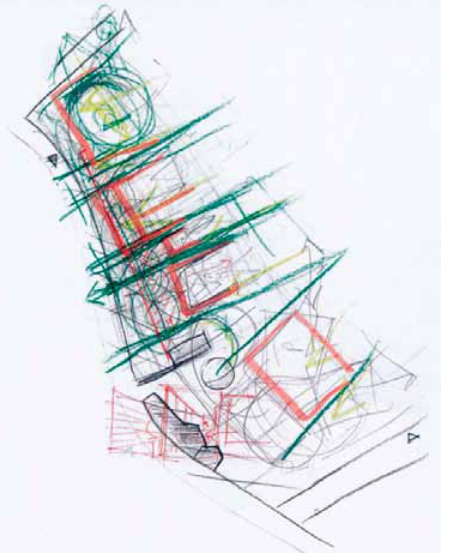
fig. 5a. Sketch of the project layout (Bellotto, Bronca 2015)